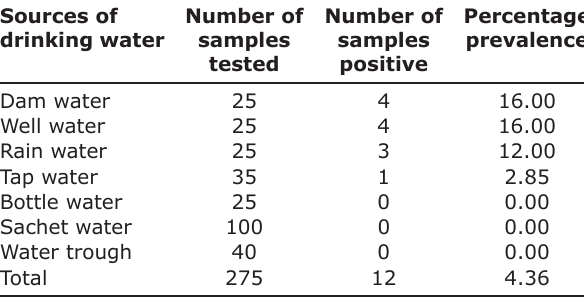
Table-1: Distribution of Salmonella species in the various drinking water sources